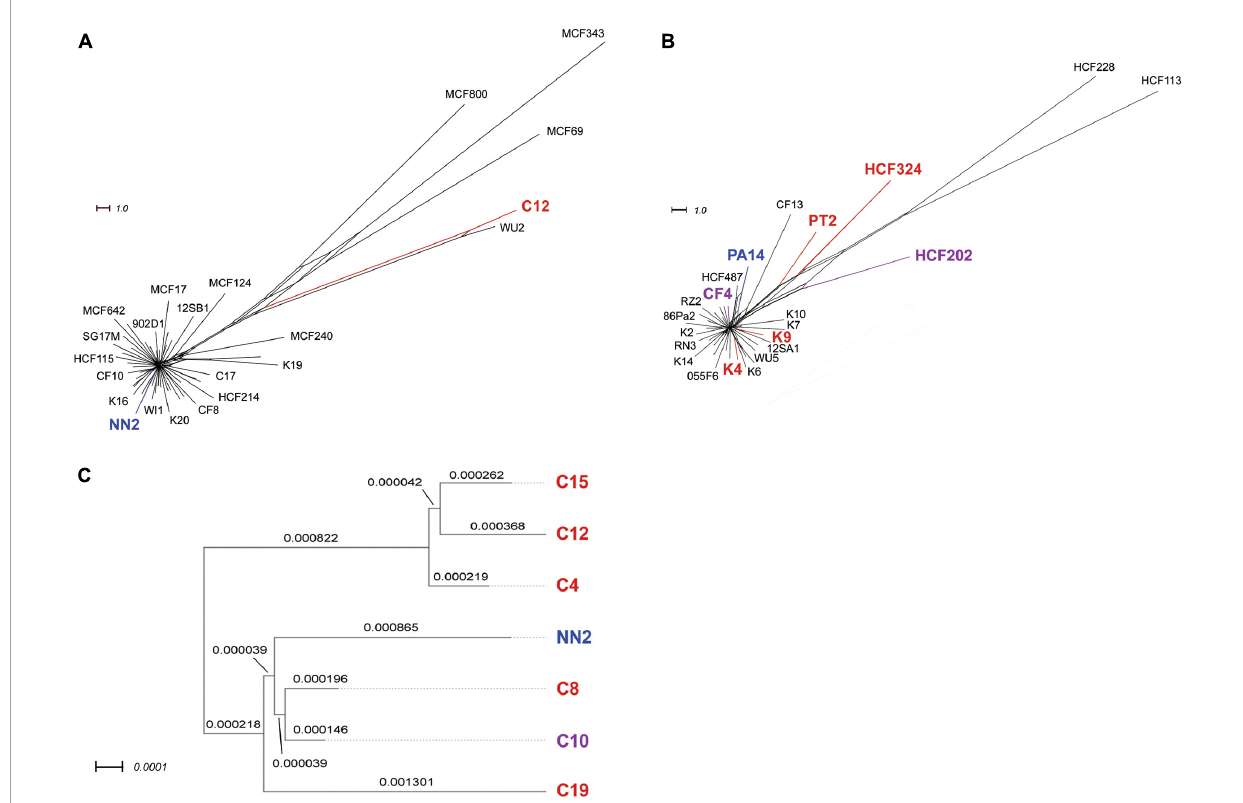
FIGURE2 Phylogenetic trees of clone C and clone PA14 strain panels. The upper panels display phylogenetic trees for collections of 58 clone C strains (A) and 42 clone PA14 strains (B) , respectively. The trees were reconstructed from results on intraclonal diversity from our in-house report (Fischer et al., 2016) who had performed SNP based phylogeny analyses of the strains’ core genome sequences. All clone PA14 isolates used in the current study were chosen from this 42 strain panel, while only one of the six clone C strains screened for inversions (C12) was included the 58 strain panel analyzed in Fischer’s work. Therefore, genome distances were calculated for the six clone C strains and the reference strain NN2, and the results were displayed in a separate tree (C) . Branch lengths are given in terms of the applied GBDP distance formula (see section “Materials and methods”). Please note that MinION data-derived genome assemblies were used for these calculations, which could contain sequencing-based single nucleotide errors. Nevertheless, sequence diversity caused by strain-specific accessory genome composition should be reflected in these